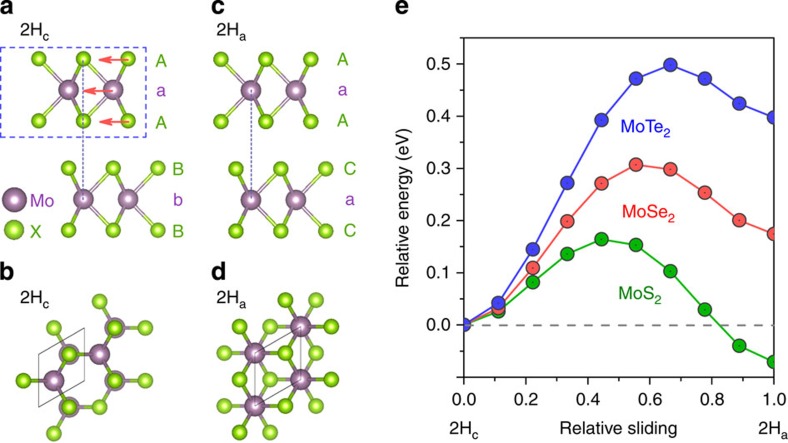
Structural details of 2Hc− and 2Ha−MoX2 and layer sliding calculations.(a) The side view (projected on ac plane) of 2Hc structure in MoS2, MoSe2 and MoTe2. X represents S, Se and Te. The red arrows represent one sliding path for the 2Hc to 2Ha transition, where one unit of X-Mo-X triple layers (marked by a blue box) shifts systematically in ab plane. (b) The top view (projected on ab plane) of 2Hc structure. (d) The side view of 2Ha structure. (c) The top view of 2Ha structure. (e) The total energy of MoS2, MoSe2 and MoTe2 as a function of relative sliding from 2Hc to 2Ha. The total energies of 2Hc structures are set to be zero as references, marked by a broken line. For MoS2, the unit cell volume was fixed at experimental data under 20 GPa35. After electronic relaxation of the atomic positions, the S-Mo-S layer distance of structure was set to be a constant during the layer sliding. The same procedures were performed on MoSe2 under 23 GPa (our experimental data) and MoTe2 under 20 GPa (theoretical data40).